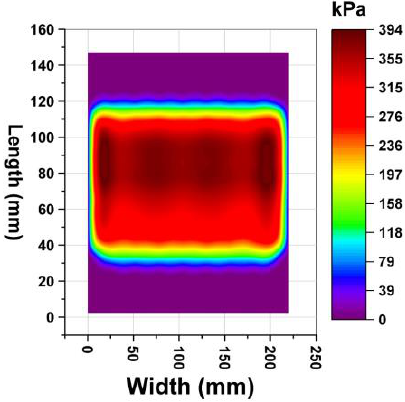
Figure 13. Vertical stress projection.